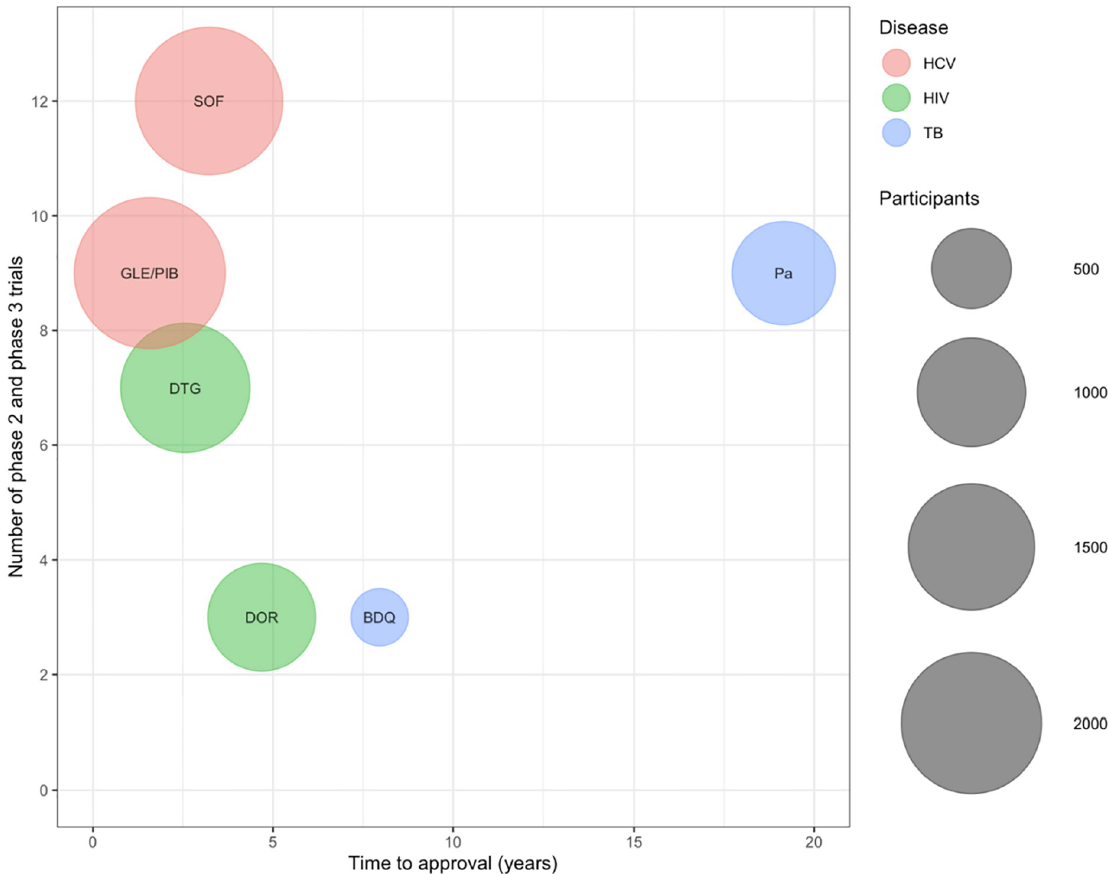
Fig 1. Number of participants, clinical trials, and time to first regulatory approval for each drug. Notes: The x-axis represents years from time to first published in vitro or clinical evidence of activity to approval. The y-axis illustrates the number of distinct phase 2 and phase 3 trials reported in the regulatory approval packages. [12–17] The bubbles are color coded by indication: blue for TB, green for HIV, and red for HCV. Their size (radius) is proportional to the total number of participants randomized (to receive the new chemical entity) across all phase 2 and phase 3 trials, as reported in the approval